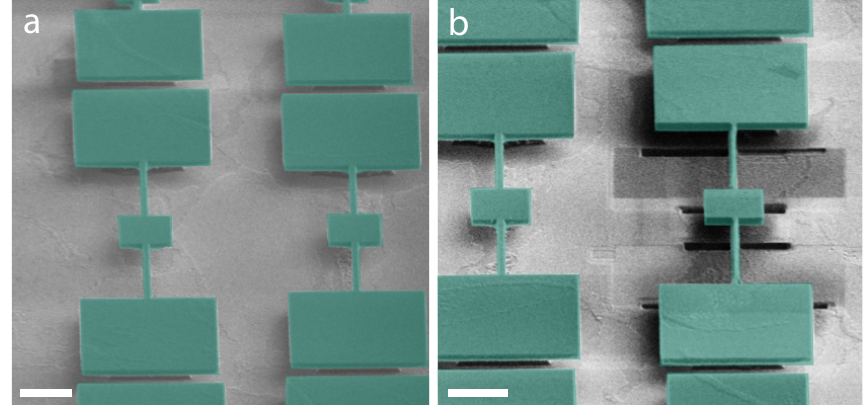
Figure 4. Cleaning nanoparticles from the corners of the device (B9). ( a ) False-color SEM image of two unclean devices: B9 (left) and B8 (right) ( b ) False-color SEM image of the clean device B9 (on the right as the image has been rotated 180° with respect that shown in ( a )). All scale bars are 3 µ